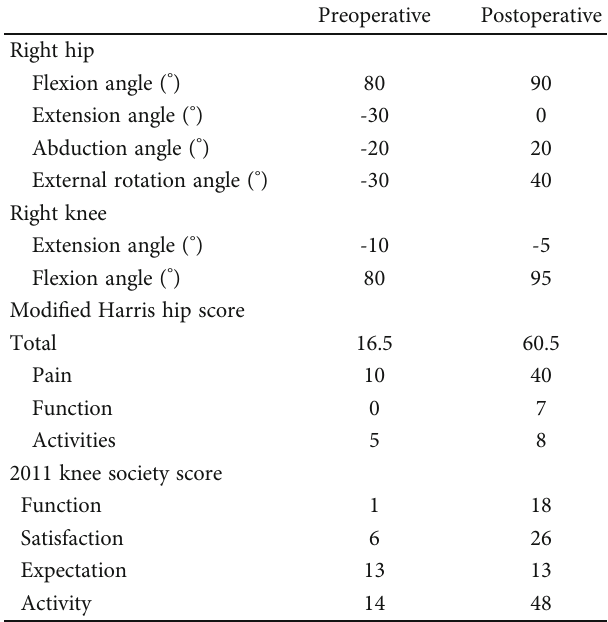
Table 1: Pre- and postoperative range of motion and clinical score of the knee and hip